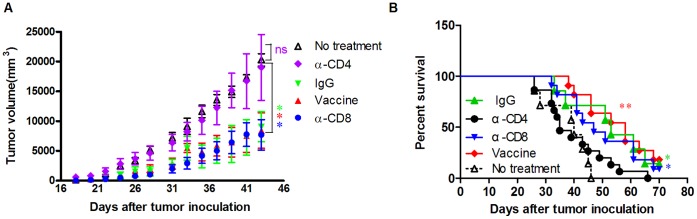
The antitumor effect of HCA587 protein vaccine is mediated by CD4+ T lymphocytes.Tumor inoculation and vaccination was performed as described above except that some groups of the mice (10–15 for each group) received additional injections of 500 µg of GK1.5 (rat anti-mouse CD4 mAb), 53-6.7 (rat anti-mouse CD8 mAb), or isotype controls 1 day before the vaccination and twice a week thereafter for a total of eight times. The group of mice (n = 7) received tumor cells but no vaccination served as controls. (A) Tumor size. Points, mean of tumor volume; bars, SE. *, P<0.05; ns, P > 0.05, compared with untreated control group. (B) Survival curve of the mice. **, P<0.01; *, P<0.05, compared with untreated control group.